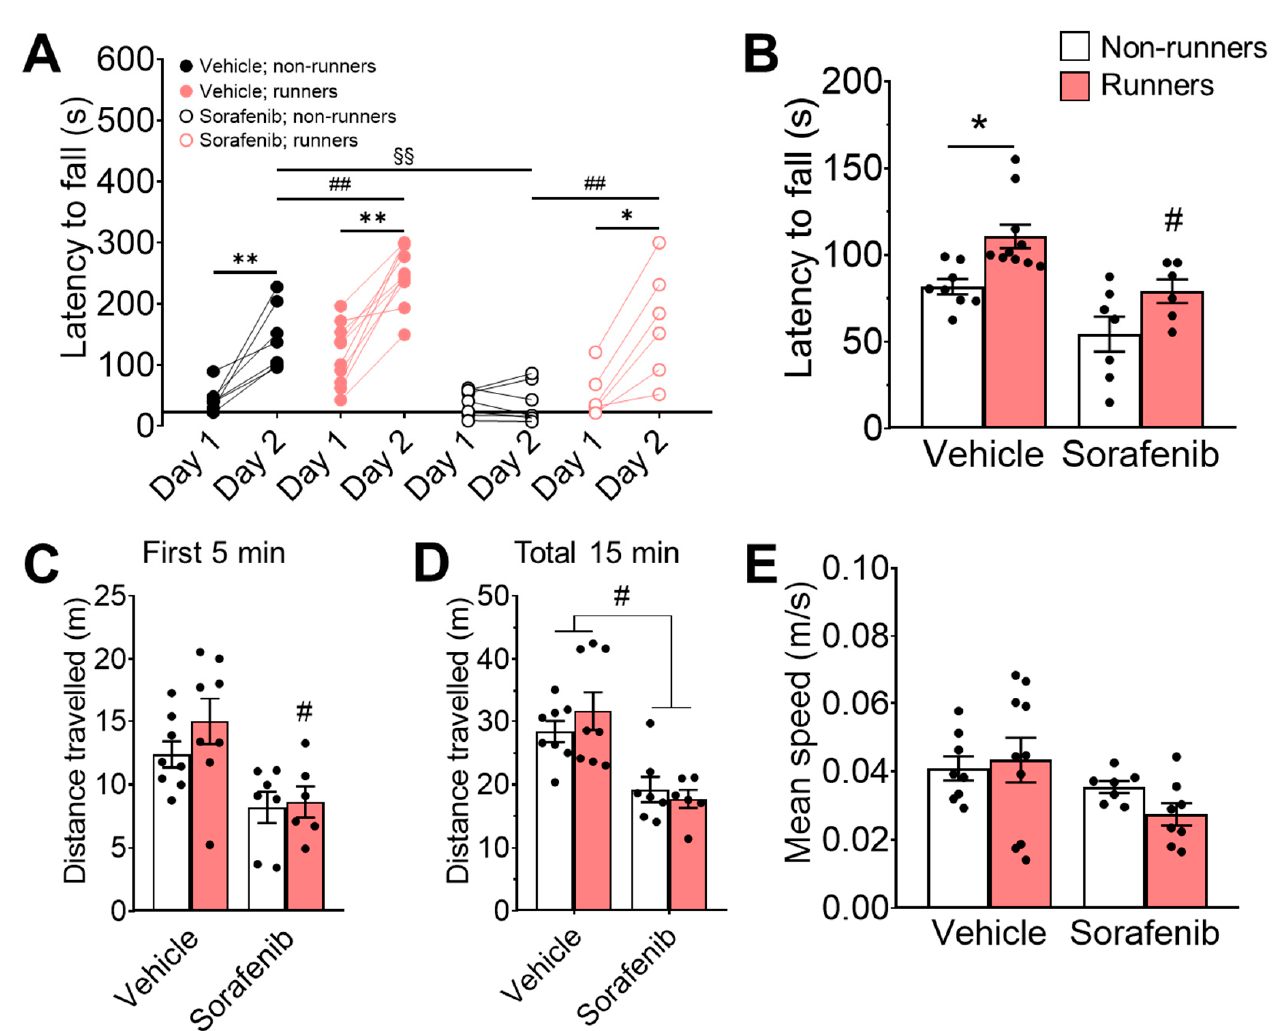
Figure 3 . Exercise ameliorated sorafenib-impaired motor learning . ( A ) Vehicle-treated and non-run- Figure 3. Exercise ameliorated sorafenib-impaired motor learning. ( A ) Vehicle-treated and